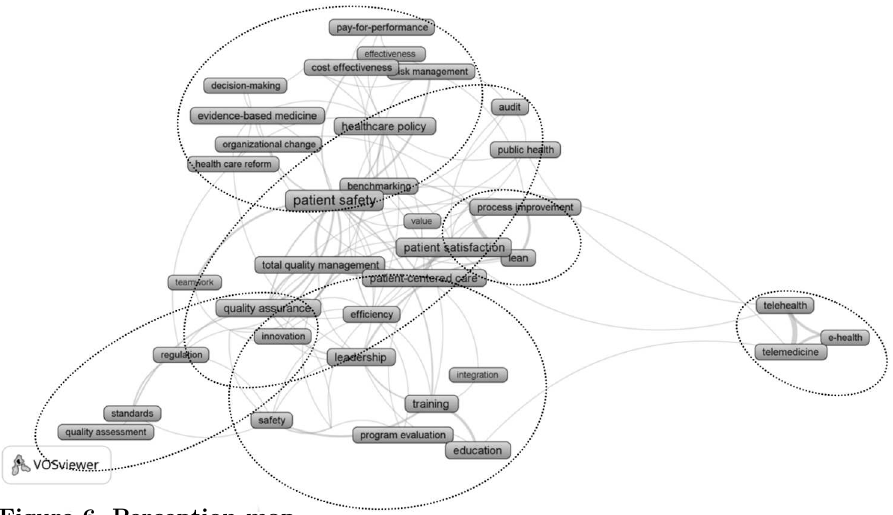
Figure 6. Perception